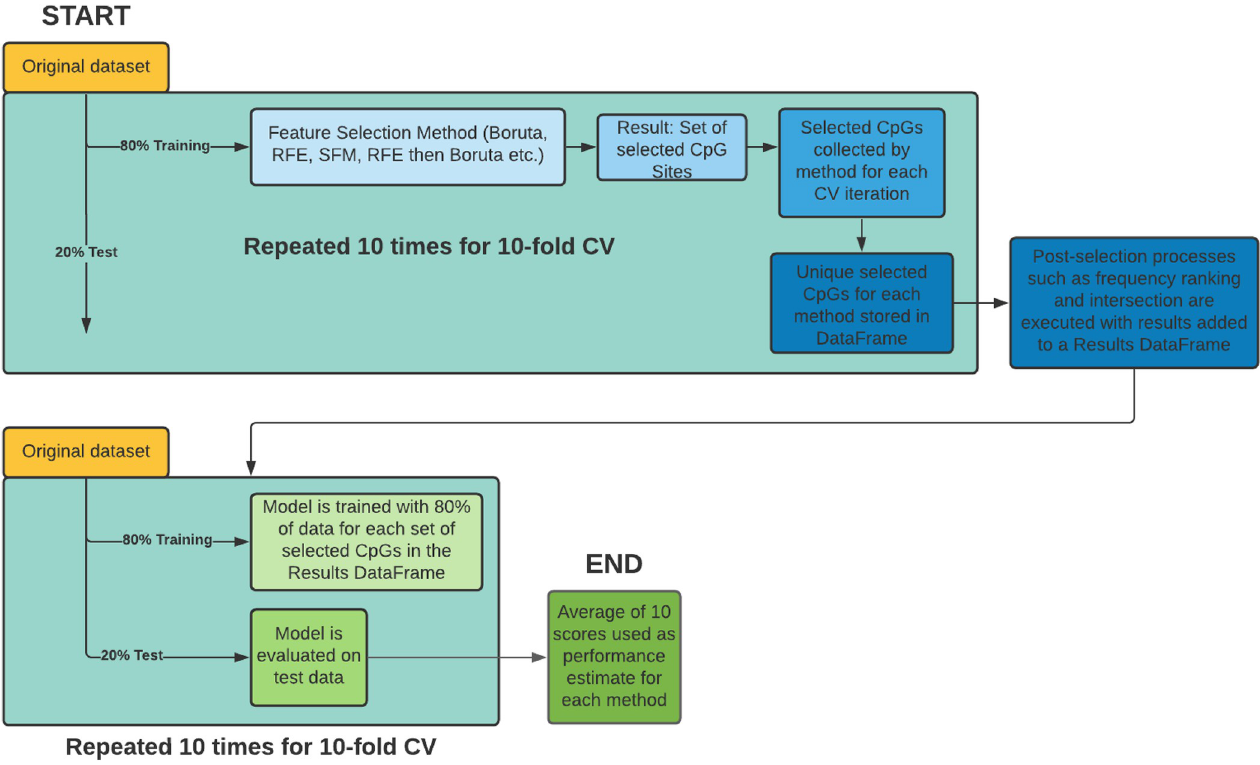
Fig 4. The workflow for feature selection and model evaluation. Feature selection was performed on training data for each iteration of 10-fold cross validation. The selected features of each iteration are aggregated into a list for each feature selection method type. The unique selected features for each method are collected into a dataframe where post-selection processes such as intersections are performed. We add the results to a dataframe. Each column of selected features in the results dataframe (each representing a different feature selection method) is tested using another training-testing split on the original data. This is done 10 times for 10-CV with the average of all scores being the performance estimate for that feature selection method.